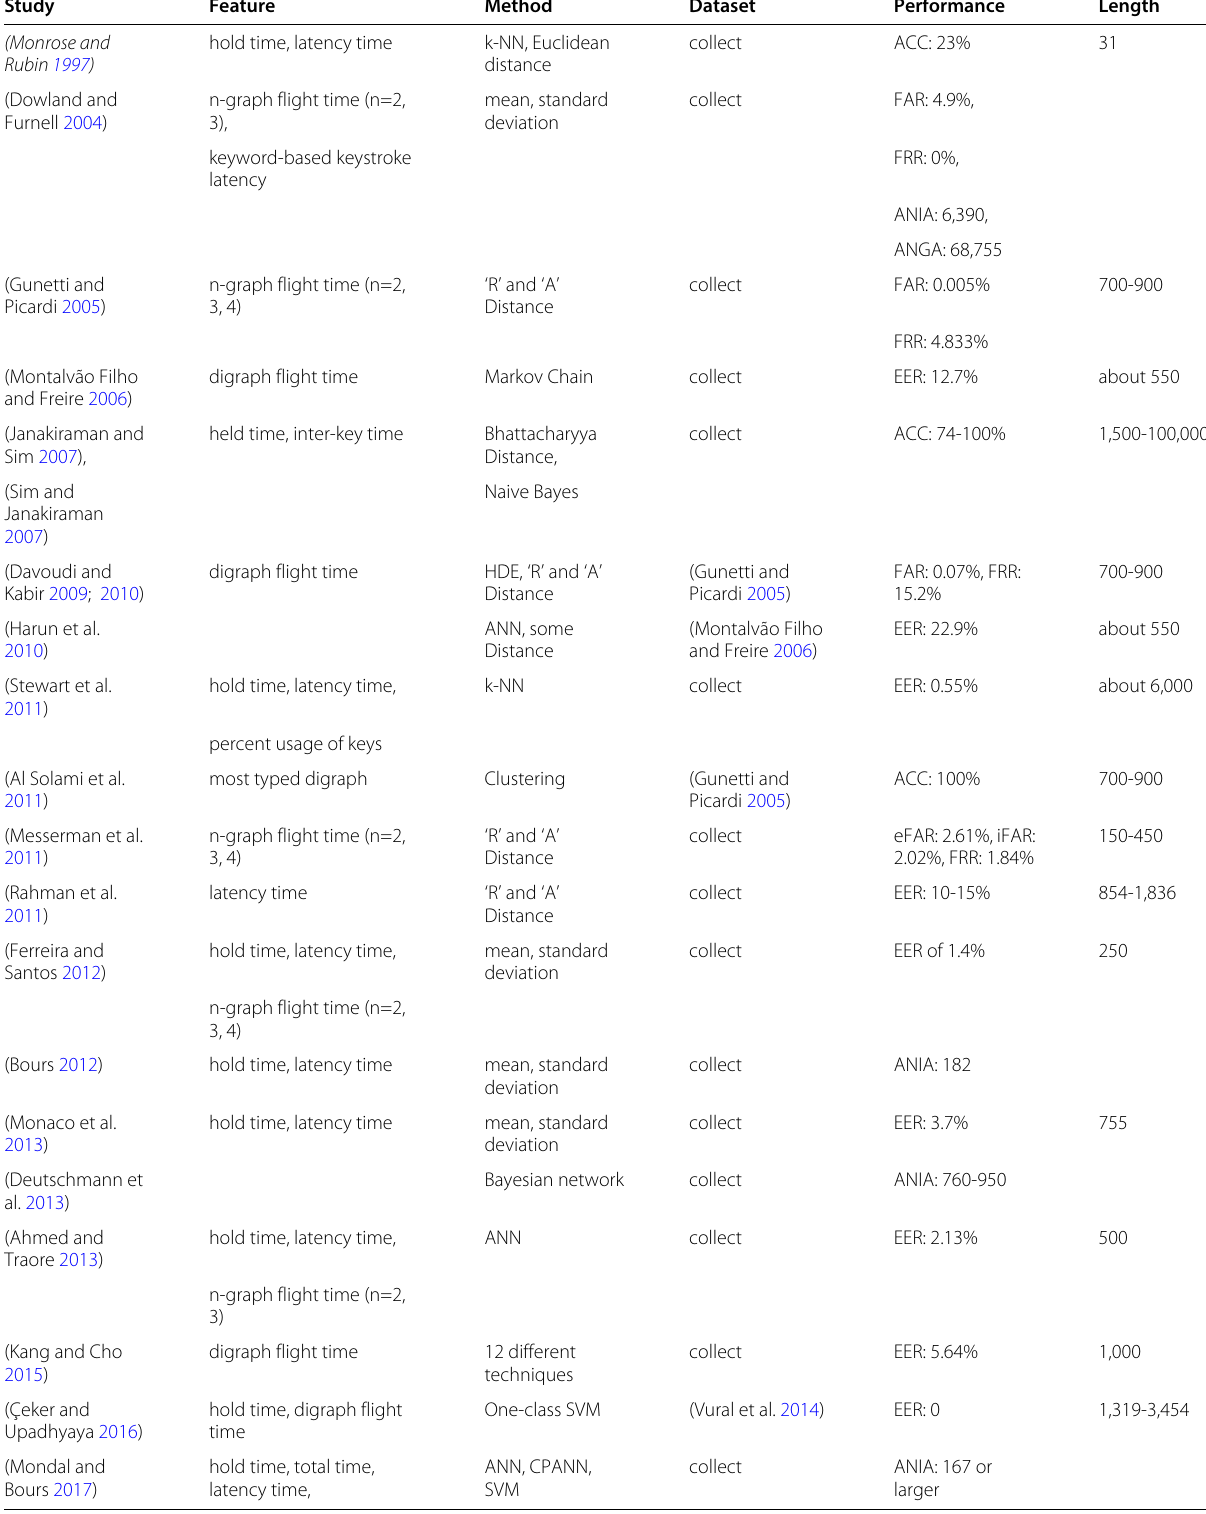
Table 1 Available KCA algorithms based on free-text keystroke